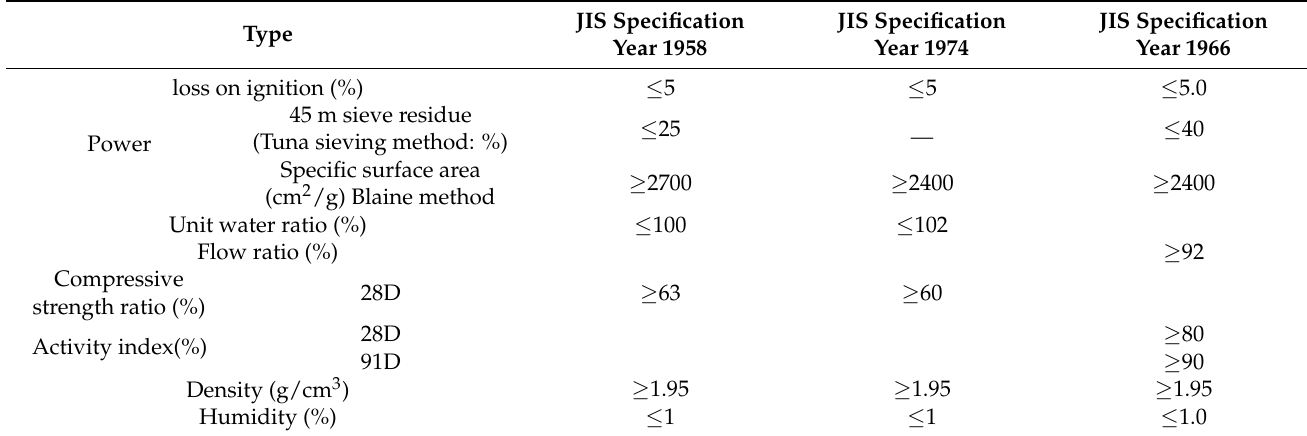
Table 1. The Japanese Industrial Standards for fly ash for concrete.